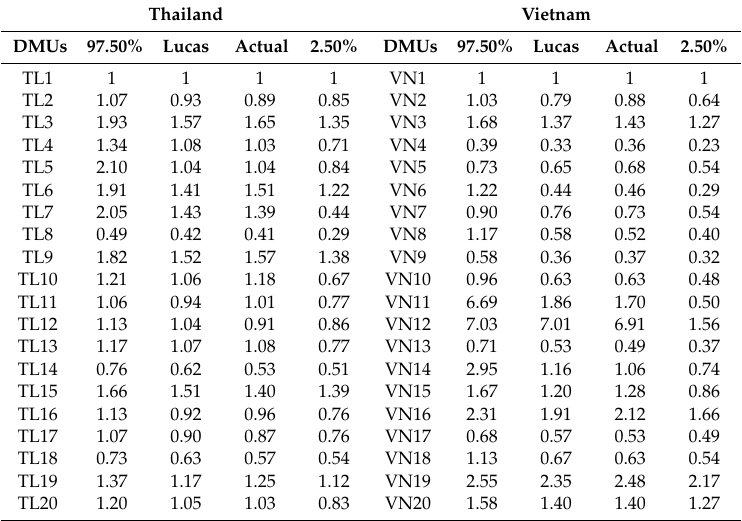
Table 7. Forecast scores vs. actual scores (2019), and confidence interval: Forecasts by the Lucas weight